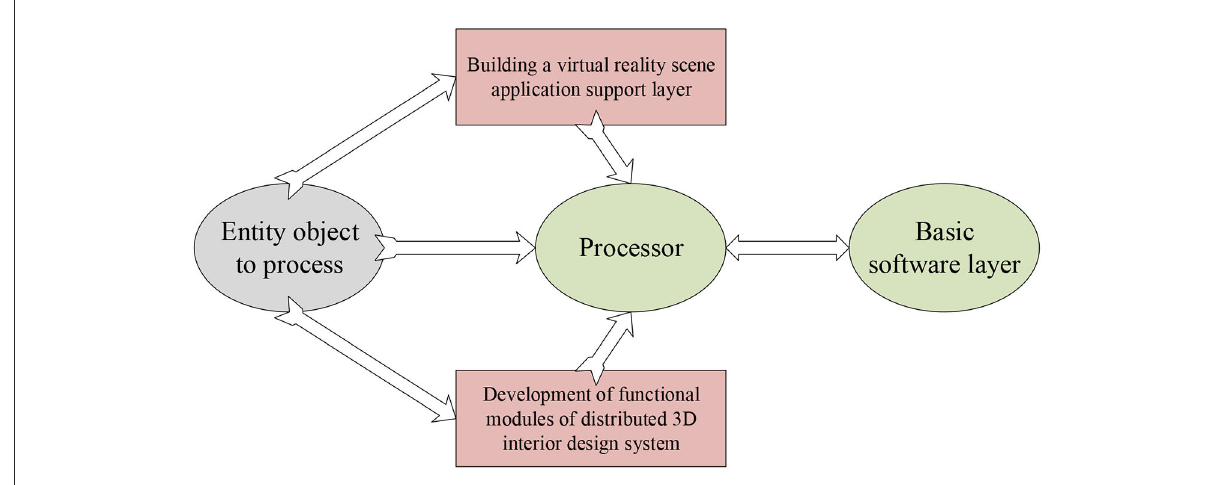
FIGURE4 Diagram of the overall architecture design of the system.